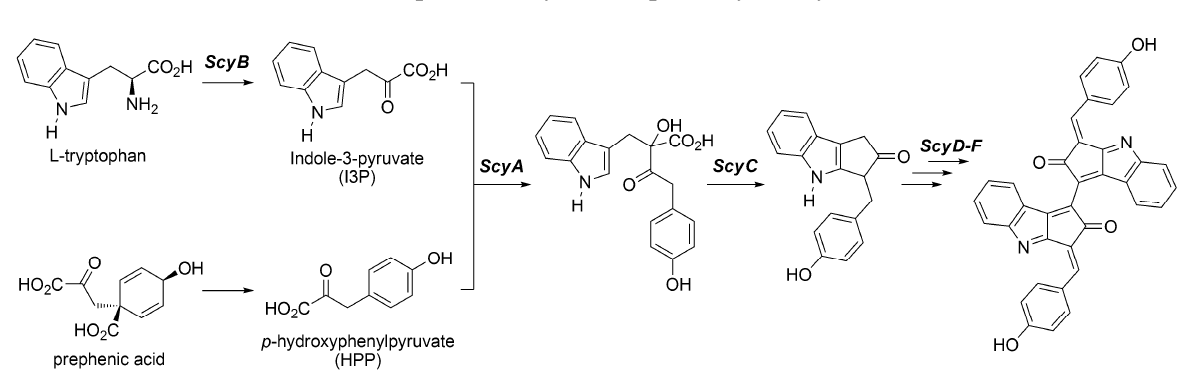
Figure 7. Proposed biosynthesis pathway of